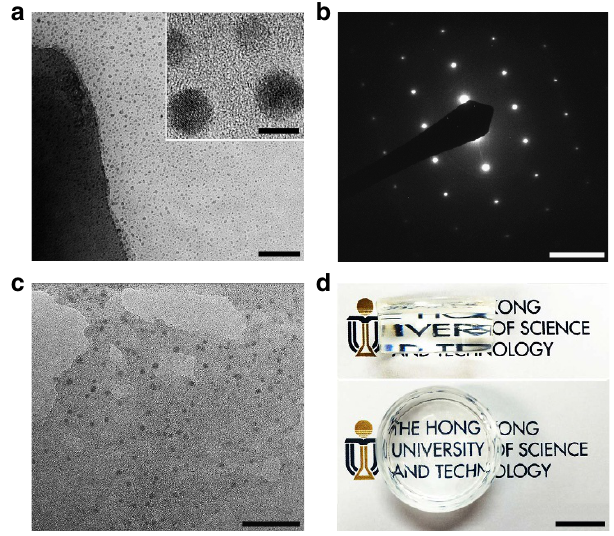
Figure 1 | PAM enhanced by non-aggregated CNS. ( a ) TEM image of CNS released from a tricalcium silicate (Ca 3 SiO 5 ) particle. The scale bars of the whole image and inset are 100 and 5nm, respectively. ( b ) Electron diffraction patterns of CNS released from a hydrolysed Ca 3 SiO 5 particle. Scale bar, 5nm (cid:2) 1 . ( c ) TEM image of CNS dispersed in C200 (PAM/CNS NC gel with 200p.p.m. CNS concentration). Scale bar, 30nm. ( d ) Optical photos of a cylindrical C200 specimen with a diameter of 2.7cm and thickness of 1.2cm against a background of characters. Scale bar, 1cm. The transparency of C200 is almost the same as the original PAM hydrogel. PAM represents polyacrylamide; CNS represents calcium hydroxide